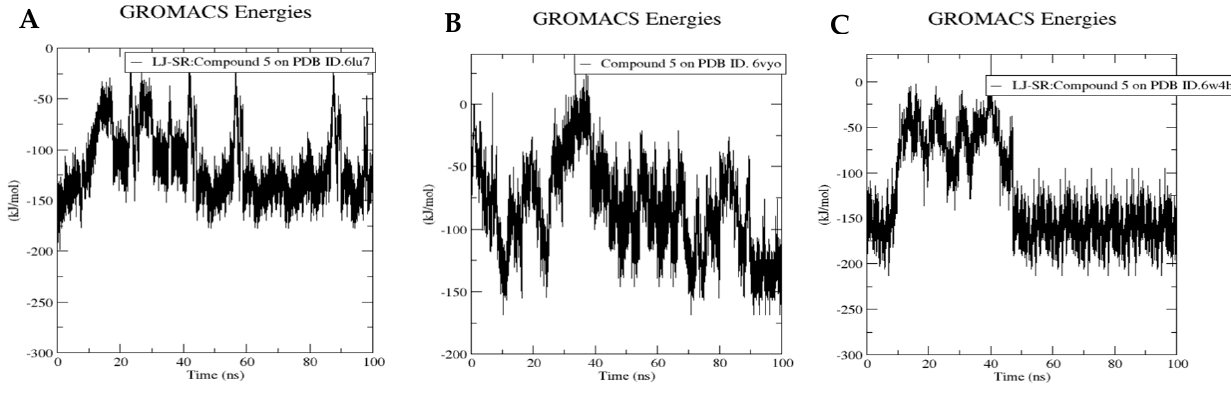
Figure 19 . Molecular dynamics of compound 5 bound to PDB ID. 6lu7 (A), 6VYO (B) and 6W4H (C) and compound 13 bound to PDB ID. 6lu7 (D), 6VYB (E) and 6VYO (F). Binding energy using LJ-SR. 4. Conclusions Fifteen structurally divergent polycyclic guanidine alkaloids were comprehensively investigated for their virtual antiviral potentials against five SARS-Cov-2 (COVID-19) pro- teins. The pentacyclic guanidinic scaffolds, crambescidins 786 (5) and 826 (13) displayed the best binding modes and free energies among the 15 investigated compounds. These docking results were confirmed with the very stable molecular dynamics simulation, opening the door to conduct more research ( in vitro and in vivo ) on compounds 5 and 13 as expected anti COVID-19 candidates. Compounds 5 and 13 exhibited very promising in silico ADMET results as well as showing high safety margins against five toxicity models. The promising ADMET and toxicity results increase the likelihood of compounds 5 and 13 being used as drugs. Author Contributions: Conceptualization, A.E.-D., A.M.M., and I.H.E.; methodology, A.M.M.; A.H.; R.K.A., and I.H.E.; software, A.M.M., A.H.; R.K.A.; E.B.E., and I.H.E.; writing—original draft preparation, A.E.-D., A.M.M., T.M.A.E.-A., and I.H.E.; writing—review and editing, A.E.-D., A.M.M., T.M.A.E.-A., E.B.E., I.H.E., R.K.A., and J.D.S.; supervision, A.E.-D., A.M.M., E.B.E., A.H., T.M.A.E.-A., R.K.A., and J.D.S. All authors have read and agreed to the published version of the manuscript. Funding: This research received no external funding. Institutional Review Board Statement: Not applicable. Informed Consent Statement: Not applicable . Data Availability Statement: Not applicable. Acknowledgments: Not applicable. Conflicts of Interest: Conflicts of Interest: The authors declare no conflict of interest.